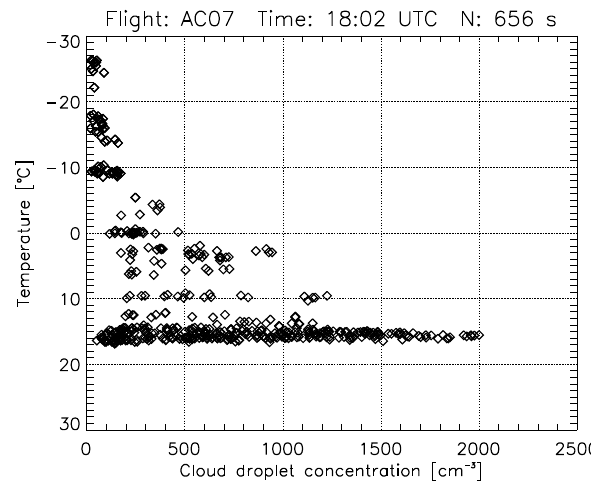
Figure 3. Cloud droplet concentration measured with CCP–CDP as a function of temperature for flight AC07. Each dot indicates a 1Hz average concentration. The sample number ( N ) and the ap- proximate start time of the cloud profile are shown at the top of the panel.